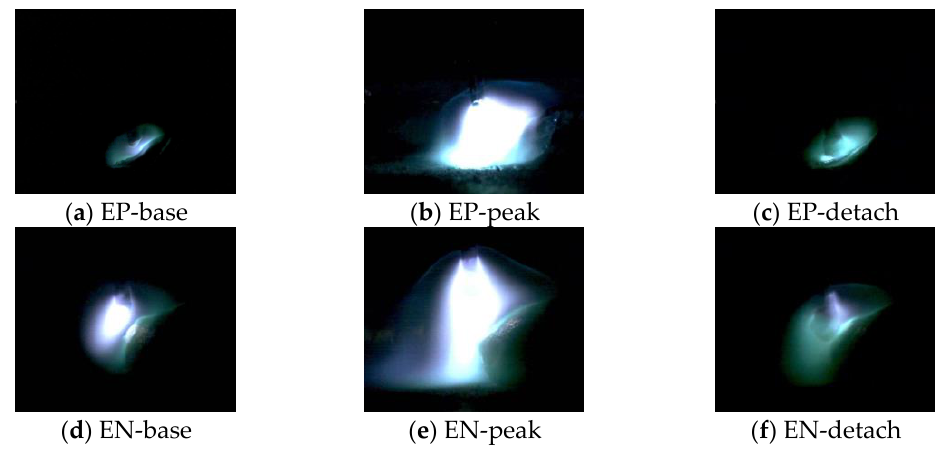
Figure 8. Arc length observations: ( a – c ) EP subphases, and ( d – f ) EN subphases.